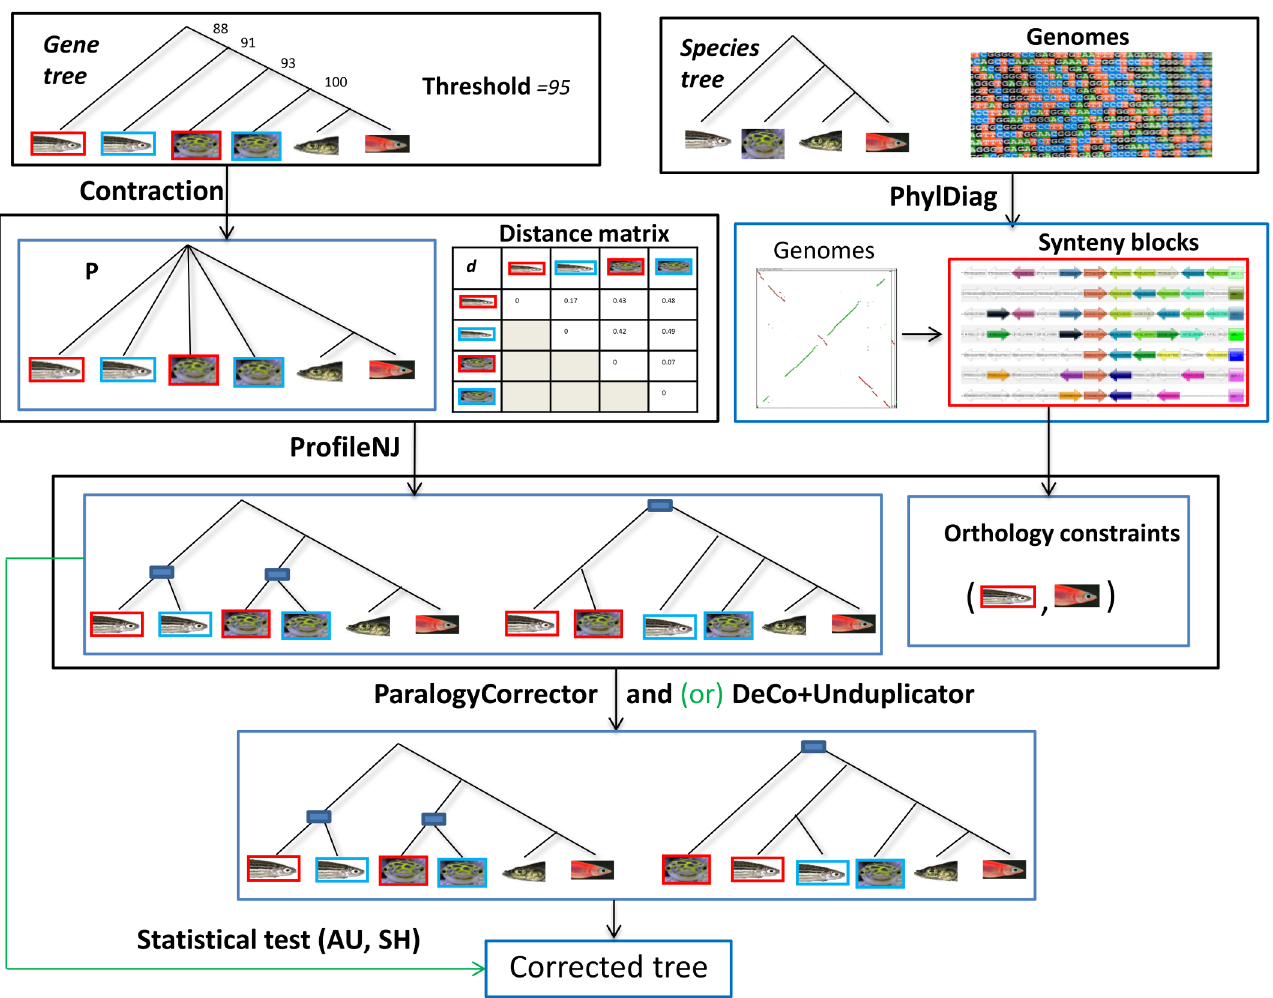
Fig 5. A general view on RefineTree when run on the Ensembl Compara gene families. An example is given for a species tree S of four fish species, a gene family of six genes (a gene is represented by the picture of the species it belongs to, and two paralogs belonging to the same species are distinguished by a different frame color), a rooted gene tree G (although it can be non rooted in general) with branch support, and a given threshold for branch contraction. Data framed in black are the input and those framed in blue are the output of the correction algorithm labeling the edge linking the considered frames. Black arrows depict the use we make of RefineTree on the Ensembl gene trees. The green arrow and the green “ or ” are alternative uses avoiding one or both of the correction tools ParalogyCorrector and Unduplicator. Any framed set of data can be alternatively provided to the pipeline as input. For example, orthology constraints obtained from various sources can be directly provided as input to ParalogyCorrector. The method for inferring orthology constraints from synteny blocks is described in the text.